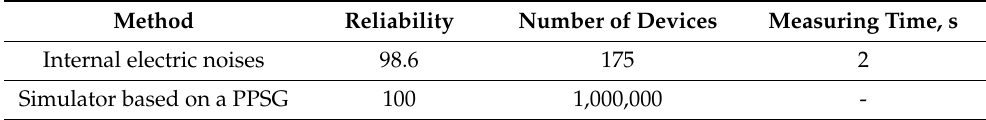
Table 6. Comparison results by efficiency parameters.